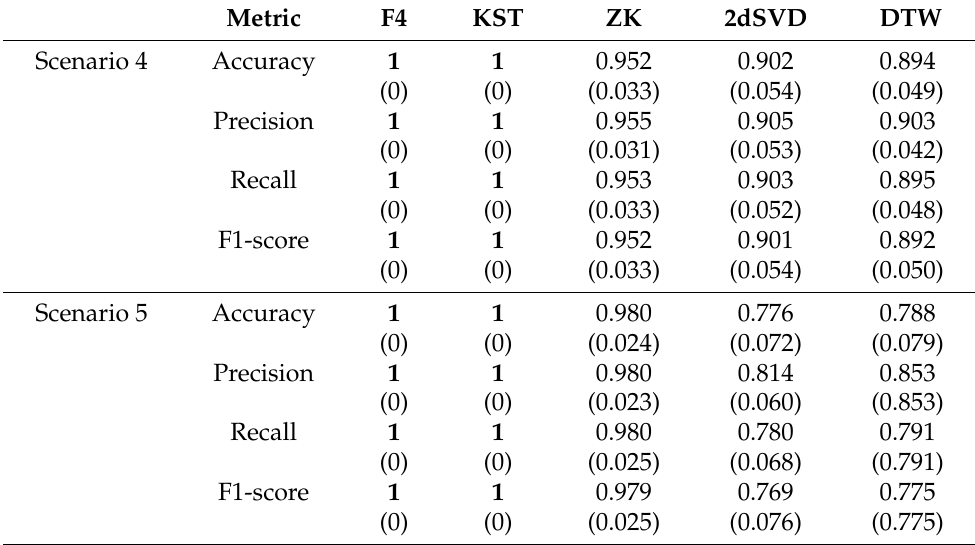
Table 5. Averages and standard deviations (in brackets) of the performance metrics for the five classifiers in Scenarios 4 and 5. For each scenario and metric, the best average result is shown in